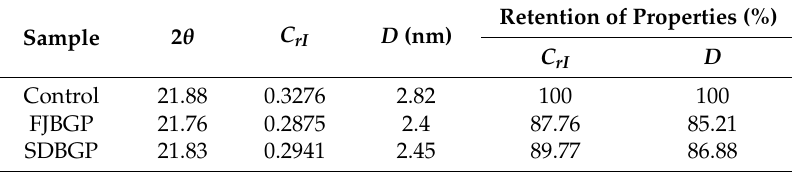
Figure 3. X-ray diffraction (XRD) patterns of the three sample groups. Table 2. Crystallinity parameters of the three sample groups.